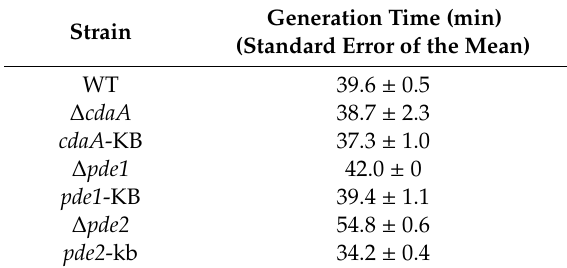
Table 3. Generation